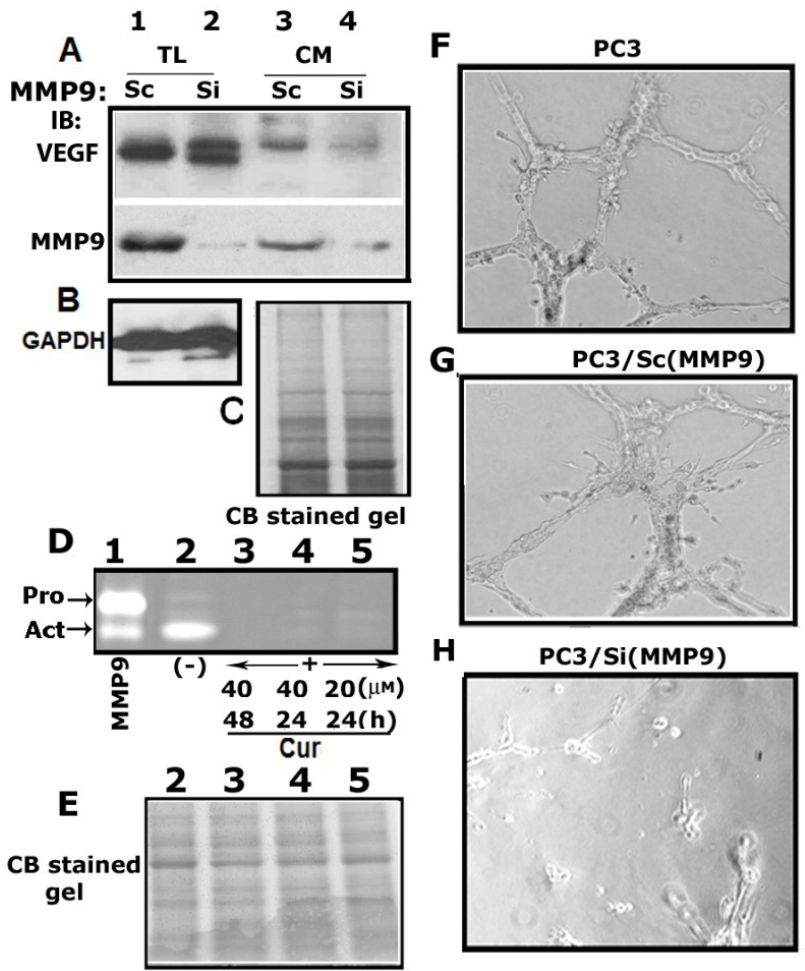
Figure 5. MMP9 plays a role in the secretion of VEGF. ( A – C ) Total cellular lysates (TL; lanes 1 and 2) and conditioned media (CM; lanes 3 and 4) made from PC3/Sc (MMP9) (lanes 1 and 3) and PC3/Si (MMP9) (lanes 2 and 4) were immunoblotted with an antibody to VEGF (A, top panel) and MMP9 (A, bottom panel). Equal amount of total cellular lysate protein (20 µg) and conditioned media (20 µg) was used for immunoblotting analysis. Blot in A was stripped sequentially and reprobed with a MMP9 to demonstrate MMP9 levels ( A , bottom panel) and GAPDH antibody to demonstrate equal protein loading in total cellular lysates ( B -left panel). Coomassie blue staining of a gel ran in parallel was used as a loading control for conditioned media ( C ). ( D , E ) PC3 cells were treated with 20 µM curcumin for 24 h (lane 5) and 40 µM curcumin for 24 (lanes 4) and 48 h (lanes 3). Untreated PC3 cells (-) were used as controls (lane 2). Equal amount of conditioned media (20 µg) was used for zymogram analysis. The activity of a recombinant MMP9 protein containing pro- and active band (indicated by arrows) was used as an identification marker (lane 1). The loading control for the conditioned media used for zymogram analysis is shown by the use of Coomassie blue staining of a gel ran in parallel ( E ). ( F – H ) Conditioned media from indicated PC3 cells (F-H) were tested for their effect on angiogenesis. HMEC-1 cells were used. Images were captured (×200) with an inverted phase contrast microscope. The results represent one of three separate experiments